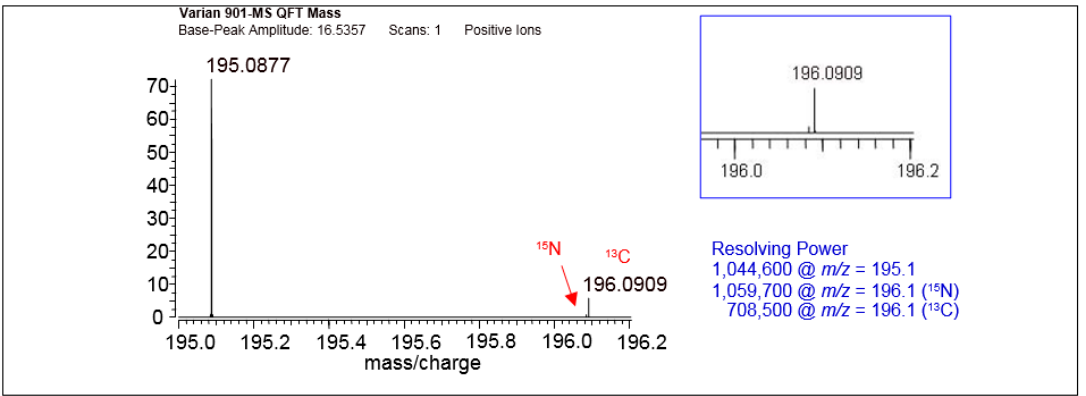
Figure 1. A high resolution spectrum of caffeine analyzed with a Varian 901-MS-QFT (Mass spectrometry-Quadrupole-Fourier Transform) mass spectrometer. The instrument was equipped with an electrospray ionization source (ZSpray) and a 9.4 T superconducting magnet.